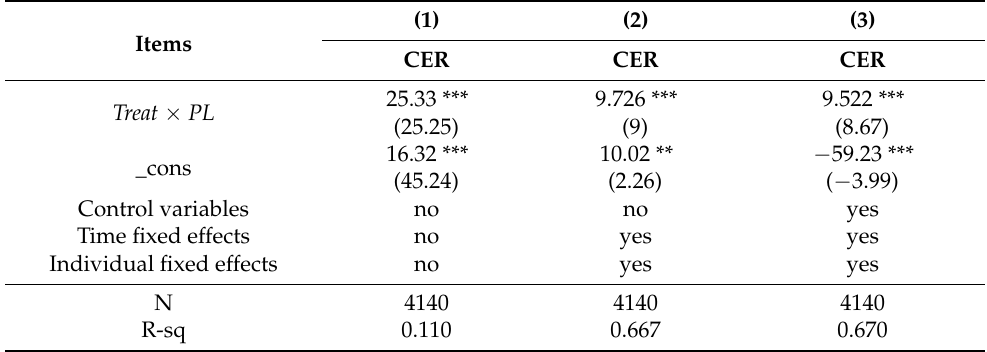
Table 3. DID regression